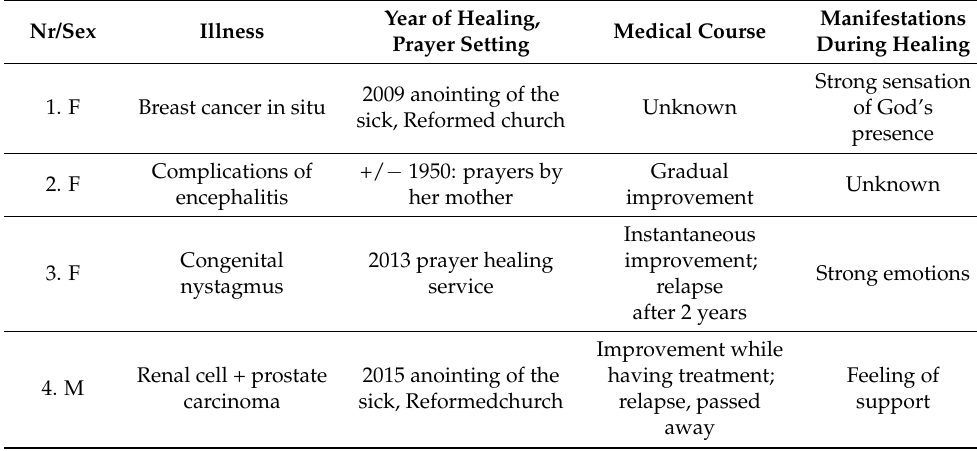
Table 9. Data of 56 reports, which were not evaluated by the assessment